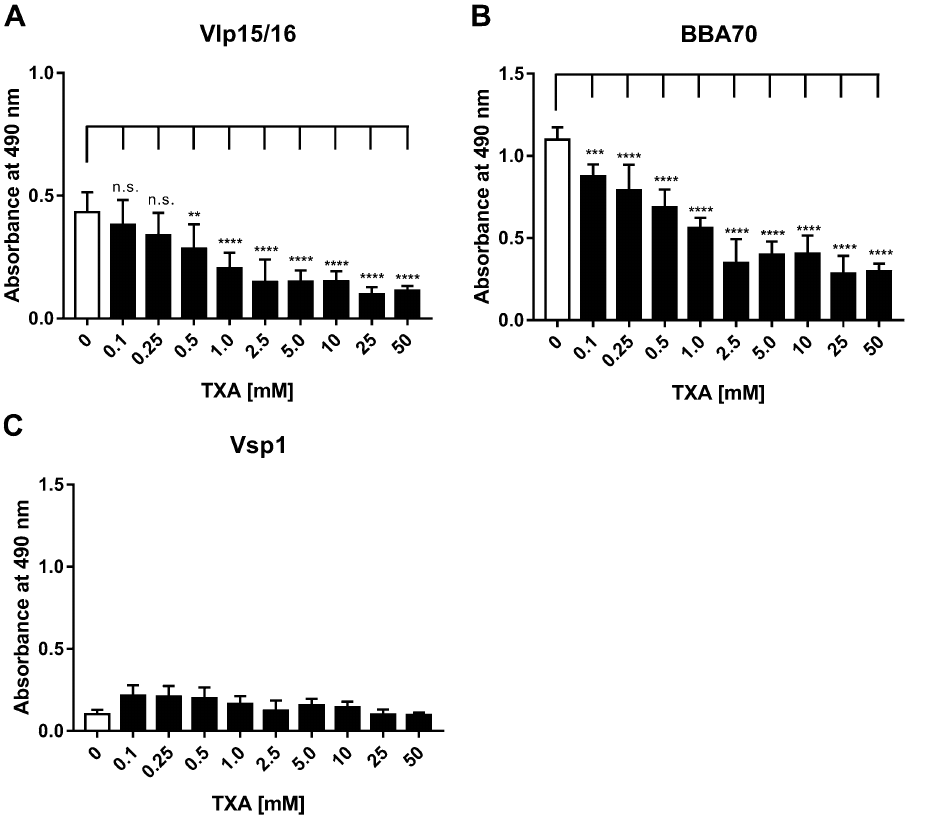
Figure 3. Involvement of lysine residues in the interaction of Vlp15/16 with plasminogen. To determine involvement of lysine residues increasing concentrations of the lysine analog tranexamic acid (TXA), Vlp15/16, BBA70, and Vsp1 (5 µg/ml each) were immobilized and incubated with plasminogen in the presence of increasing concentrations of tranexamic acid. Bound plasminogen was detected by a polyclonal antibody (1:1000). Three independent experiments were conducted in triplicate and graphs represent means ± SEM. *p ≤ 0.033; **p ≤ 0.002; ***p ≤ 0.0002; ****p ≤ 0.0001; n.s., no statistical significance, one-way ANOVA with post- hoc Bonferroni multiple comparison test (confidence interval =